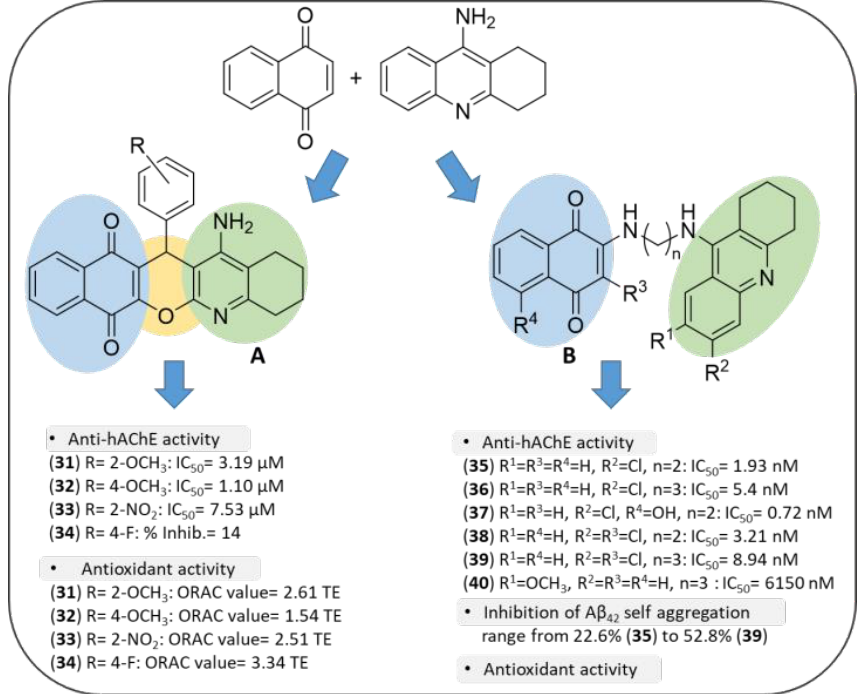
Figure 9. NQ-tacrine hybrids as MTDLs. QuinoPyranTacrines ( A ) and NQ-tacrine hybrids ( B ).